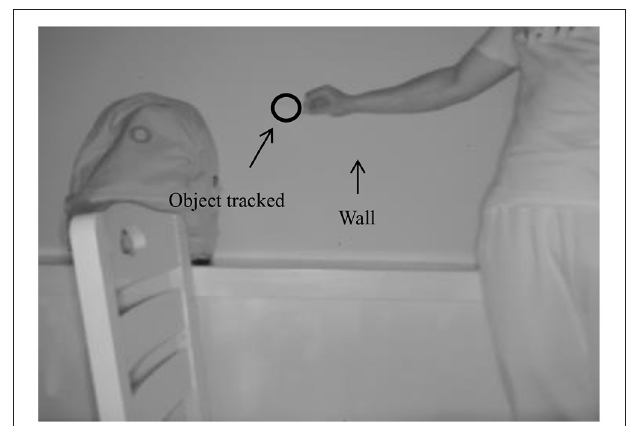
FIGURE 2 | The 28th frame.